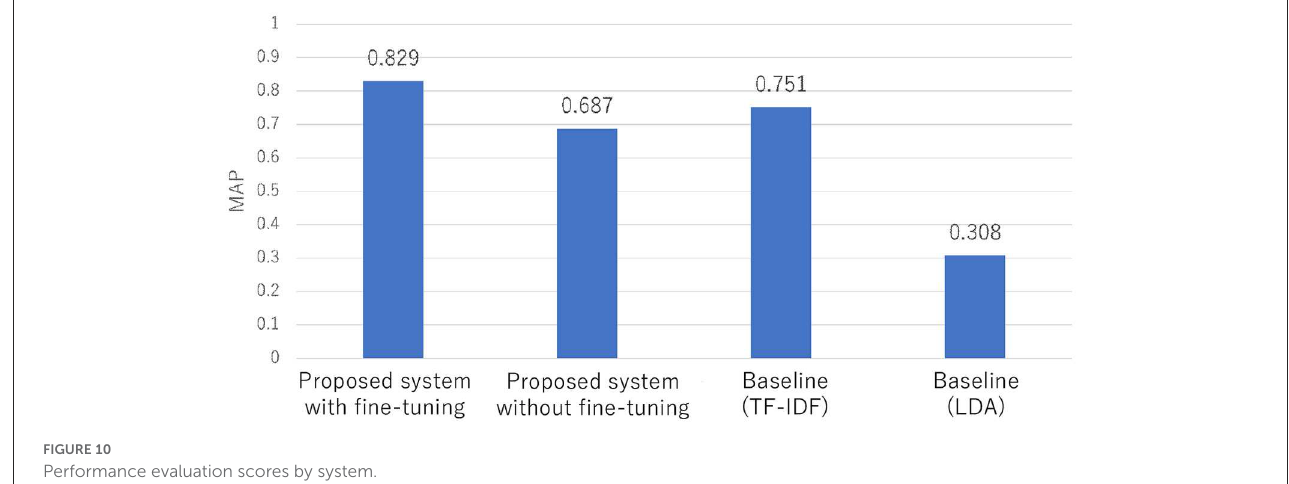
FIGURE10 Performance evaluation scores by